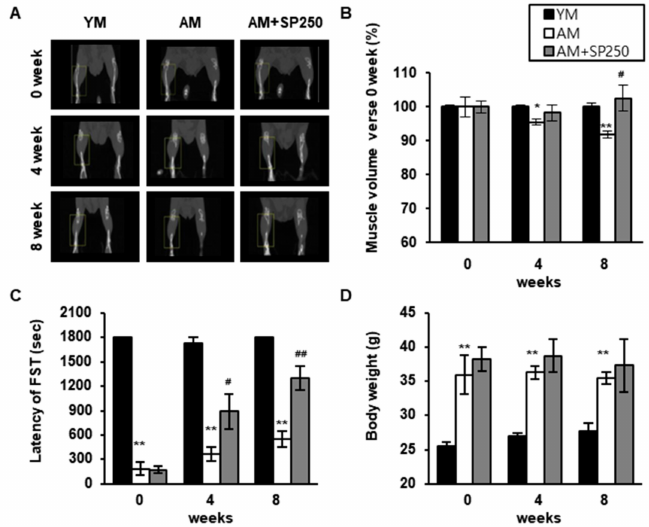
Figure 7. E ff ect of SP on muscle size and strength, and body weight in adult mice. ( A ) Micro-CT image of hindlimb muscle. ( B ) Relative hindlimb muscle volumes were quantitated compared with those of 0 week. ( C ) Latency of the forced swimming test was measured for 30 min. ( D ) Body weight of the mice after 8 weeks of the experimental period. * p < 0.05, ** p < 0.01 compared to young mice group at 0 week; # p < 0.05, ## p < 0.01 compared to adult mice group at 0